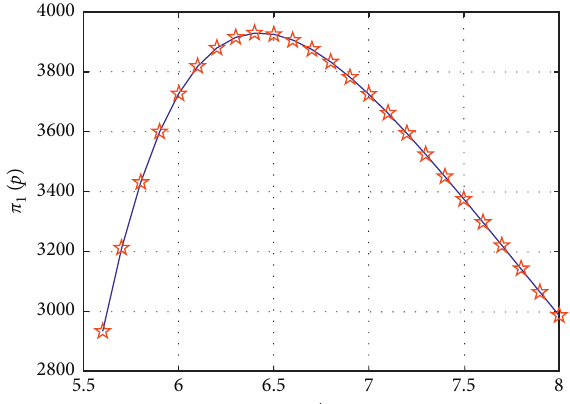
Figure 2: The effect of price on profits.